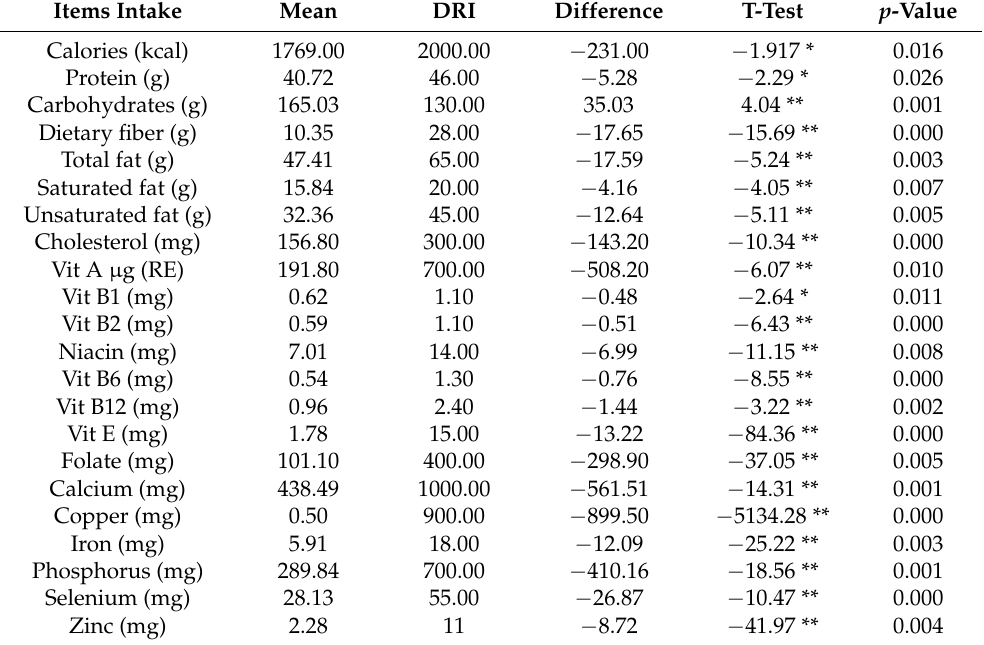
Table 2. Average daily intake of nutrients (24 h recorded—3 days) with the dietary requirement intake (DRI) for females with CD ( n = 51) using the